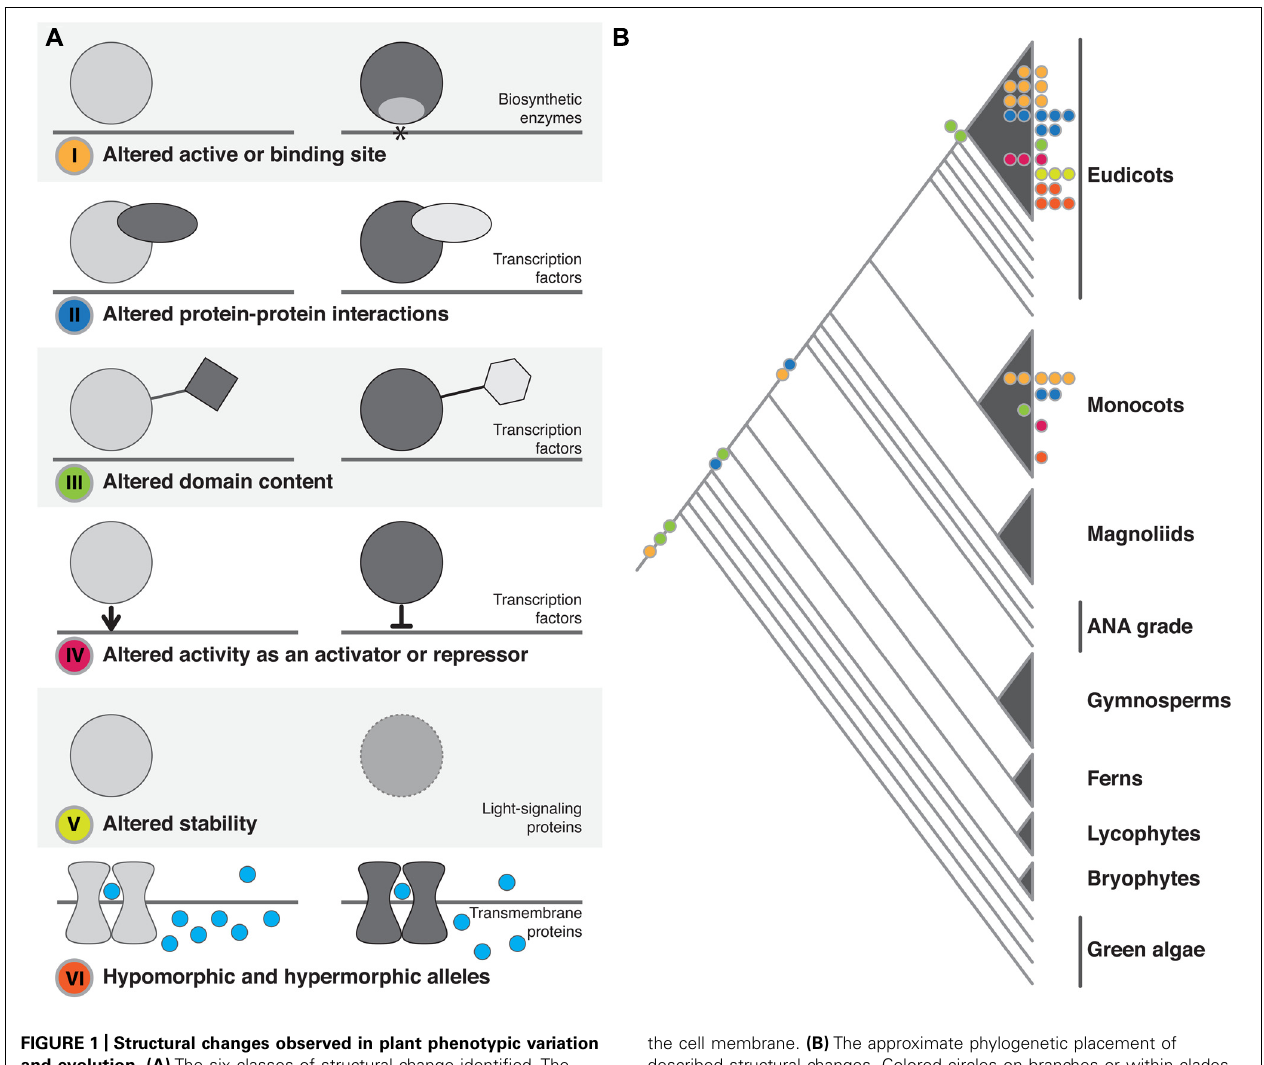
FIGURE 1 | Structural changes observed in plant phenotypic variation and evolution. (A) The six classes of structural change identified. The dominant family of proteins identified as being affected by each class of change is noted. In I–IV the gray line represents DNA, in VI it represents